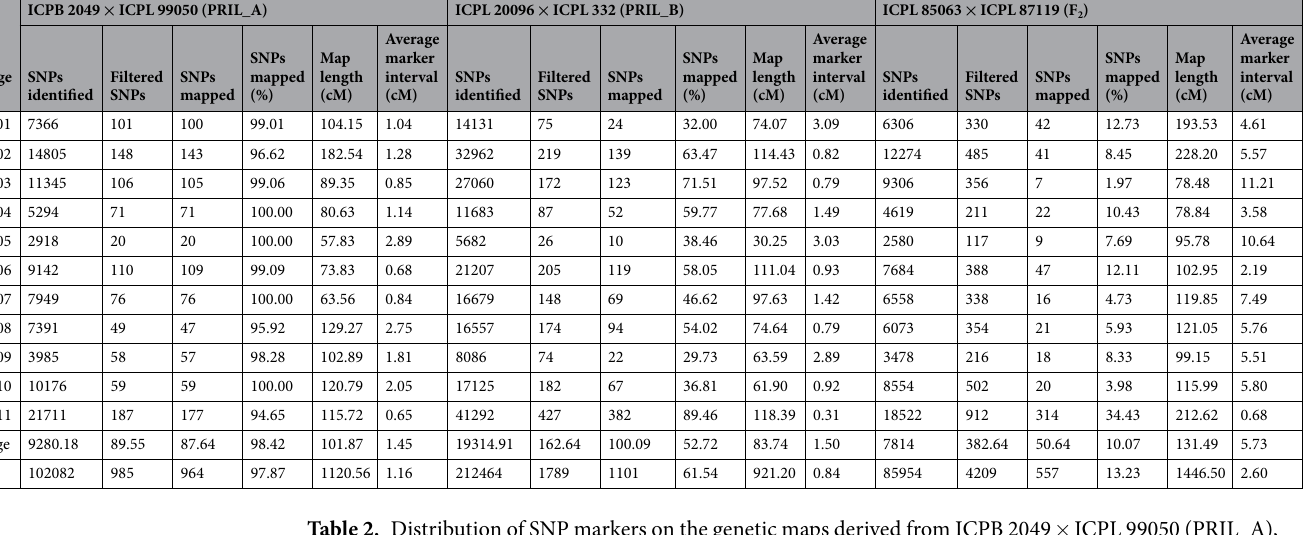
Table 2. Distribution of SNP markers on the genetic maps derived from ICPB 2049 × ICPL 99050 (PRIL_A),